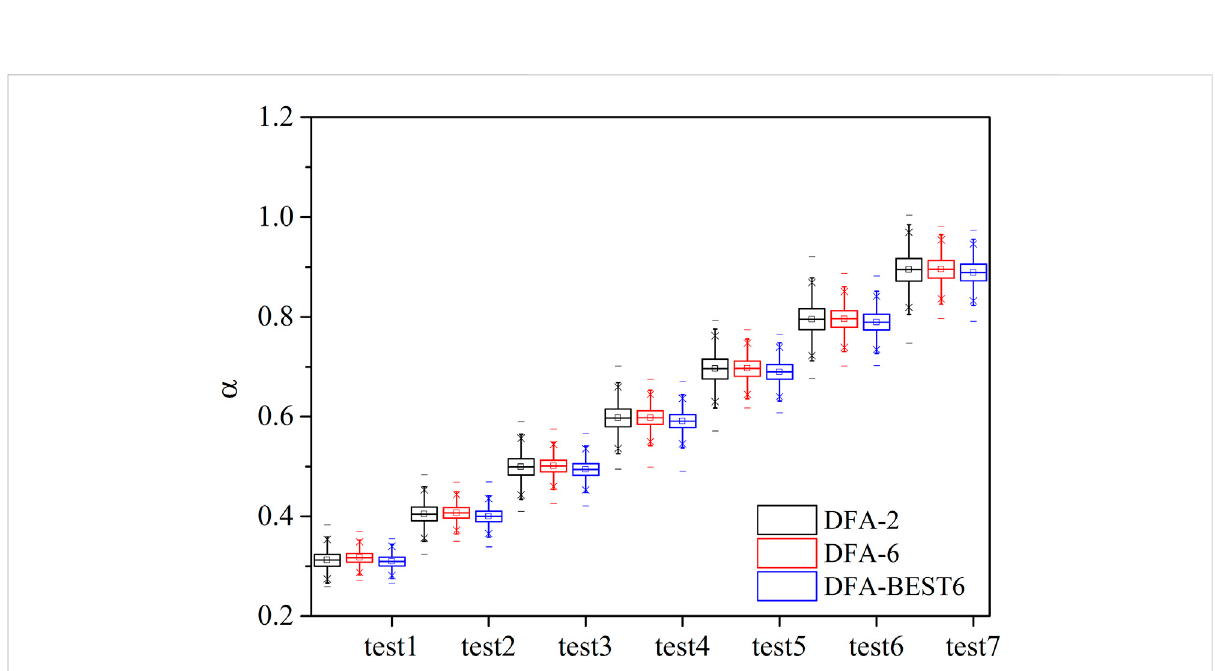
FIGURE 2 The box chart for results of DFA-2, DFA-6 and DFA-BEST6 methods for 10,000 time